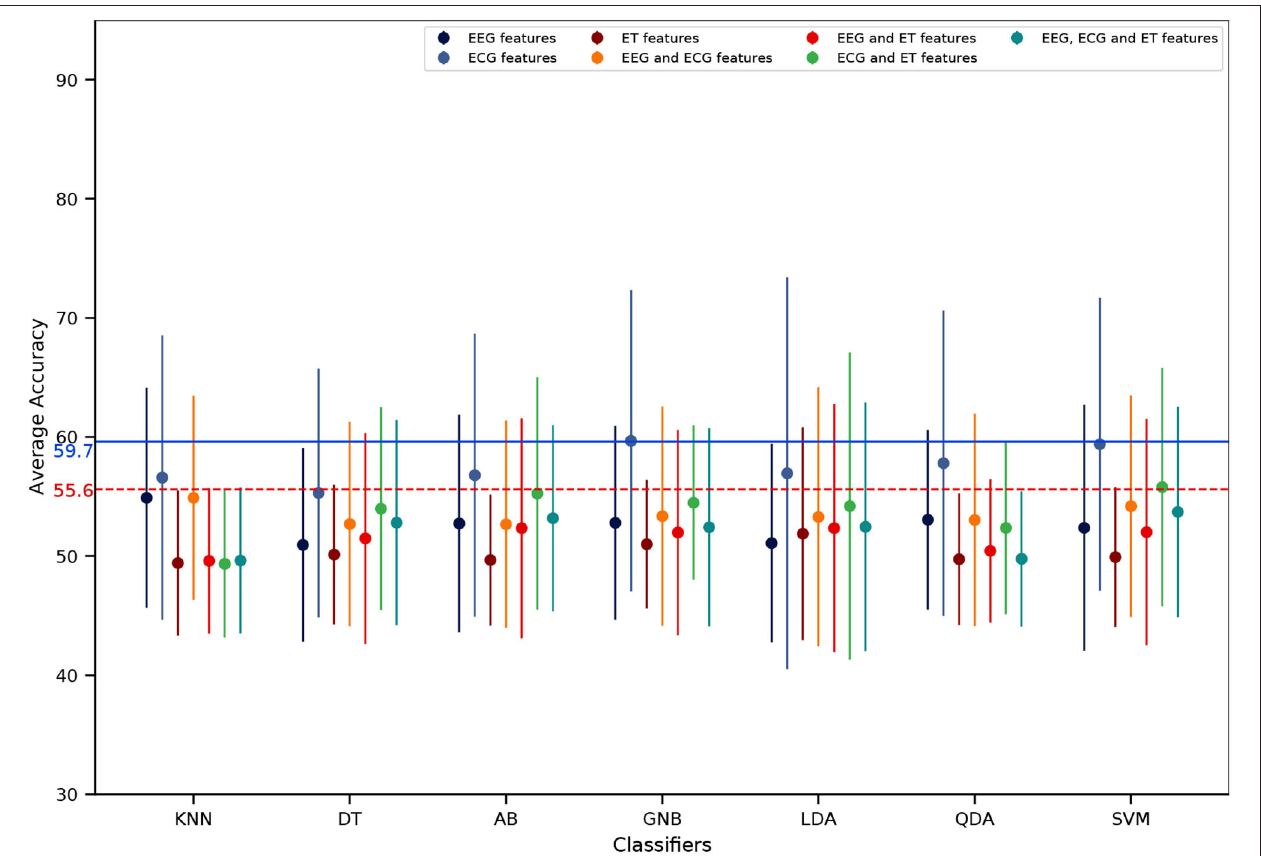
FIGURE 12 | Intra-subject mental workload estimation results per features and classifiers with the ecological validation design (average across participants). The dots represent the average score of each feature combination and the vertical line represents the associated standard deviation. The dashed horizontal red line represents the adjusted chance level while the blue one represents the highest classification